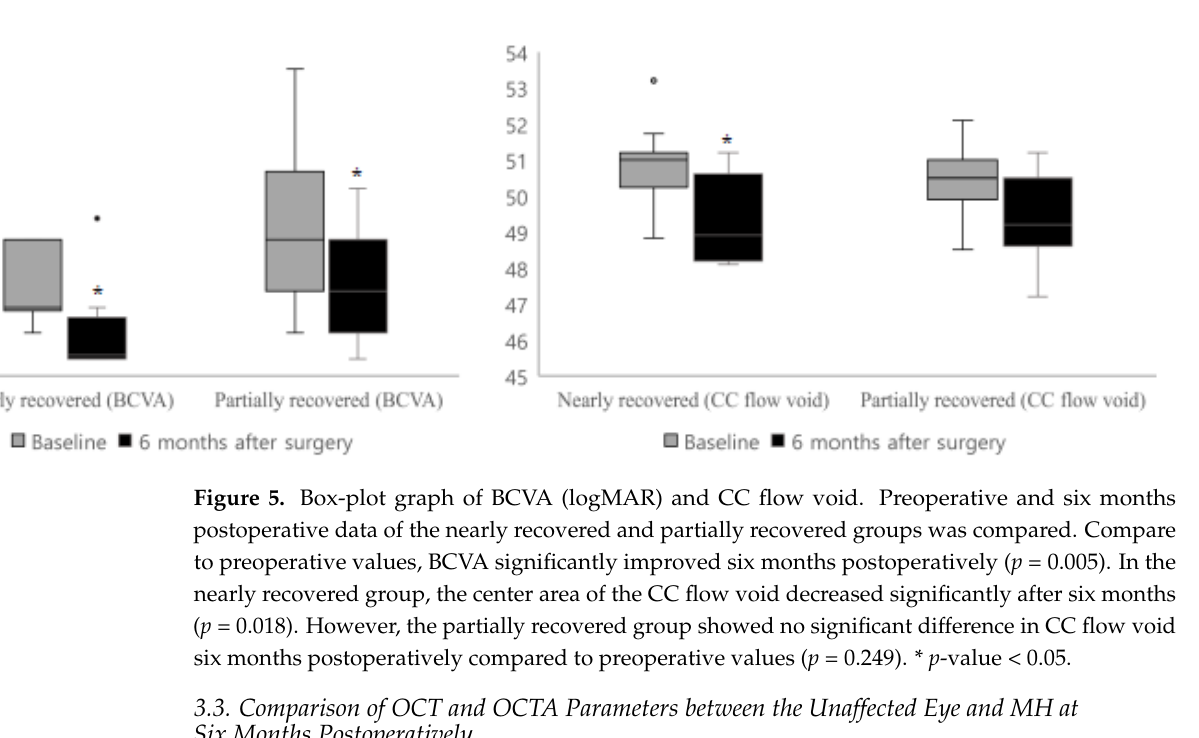
Figure 4. Box-plot graph of BCVA (logMAR) and CC flow void of MH patients. Preoperative data and data at three and six months were compared. BCVA significantly improved three and six months compared to preoperative data (p <0.001). Total area of CC flow void decreased three months postoperatively, yet this difference was not statistically significant (p=0.81). However, cho-